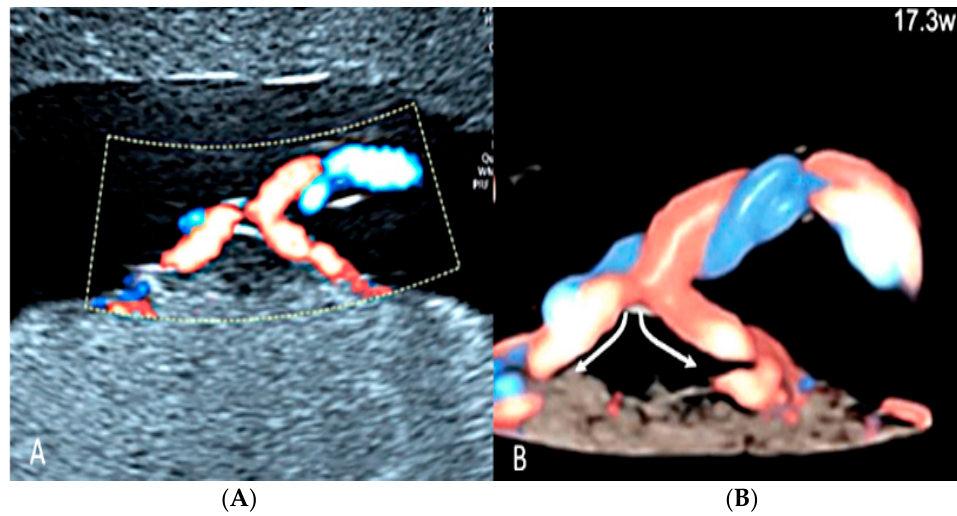
Figure 24. Furcate umbilical cord insertion using two-dimensional ultrasound ( A ) and three-dimensional ultrasound ( B ) with HD-Flow™ Doppler: the dichotomic direction of the umbilical blood flow is clearly demonstrated at 17.3 week’s gestation (arrows).